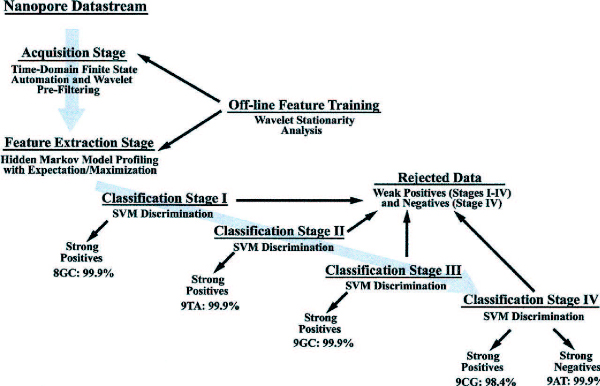
Classification technique adopted by Winters-Hilt et al. Source [6]